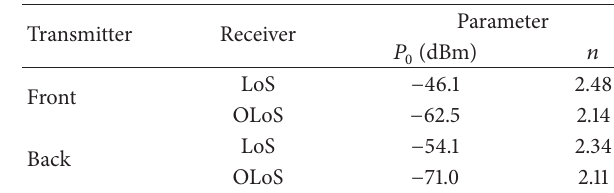
Table 2: Propagation model parameters, eucalyptus forest.